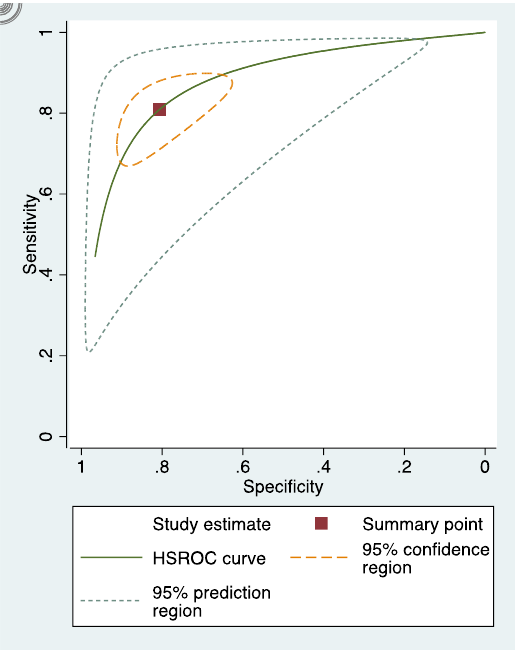
Figure 6. sRoc curves of fluorescence-based methods on occlusal surfaces.